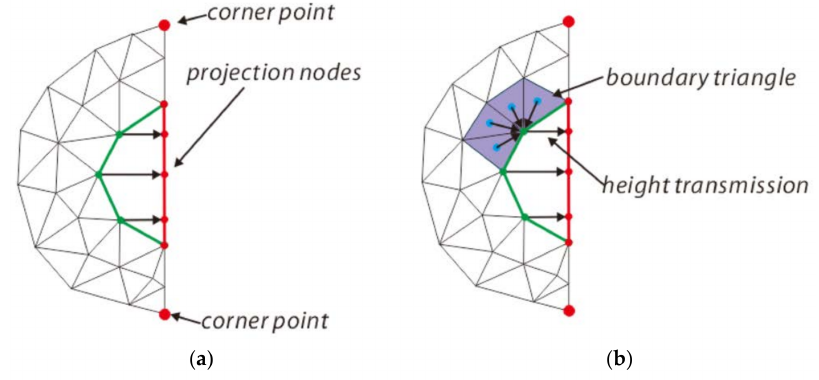
Figure 8. Grid boundary assignment: ( a ) point projection; ( b ) height transmission.